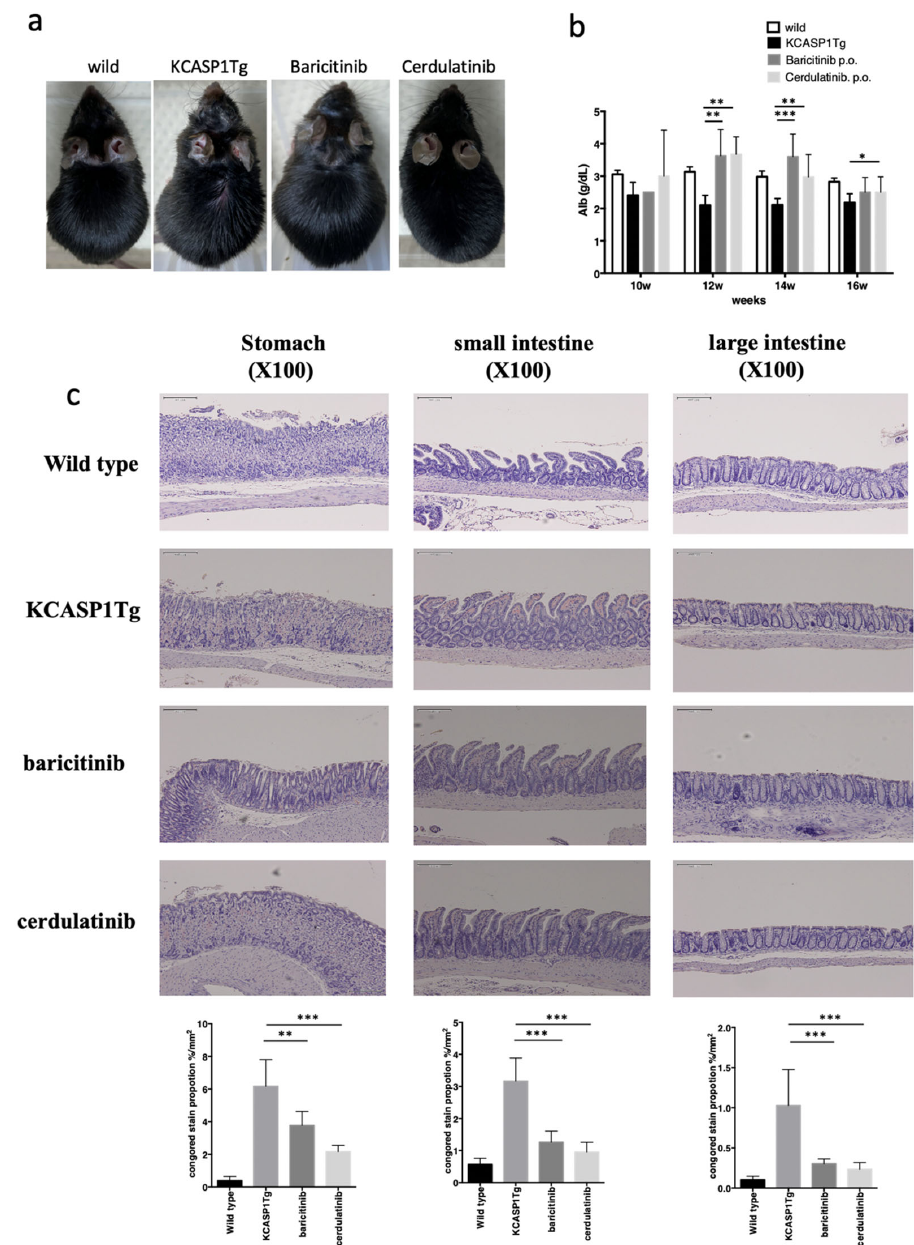
Figure 6. The effect of administration of JAK inhibitors in the KCASP1Tg mice. KCASP1Tg mice were treated with baricitinib or cerdulatinib (baricitinib and cerdulatinib, respectively). The clinical phenotype was ameliorated by both JAK inhibitors ( a ). Plasma Alb levels were measured from 10 to 16 weeks of age. Plasma Alb was recovered in baricitinib ‐ and cerdulatinib ‐ treated mice ( b ). At 16 weeks of age, the stomach, small intestine, and large intestine were collected and stained with Congo red. Amyloid deposition was reduced in the gastric mucosa and intestinal epithelial cells of the baricitinib ‐ and cerdulatinib ‐ treated KCASP1Tg mice compared with those of the non ‐ treated KCASP1Tg mice ( c ). Scale bar = 100 μ m. * p < 0.05, ** p < 0.01, *** p < 0.001 compared to KCASP1Tg mice by Kruskal–Wallis test.